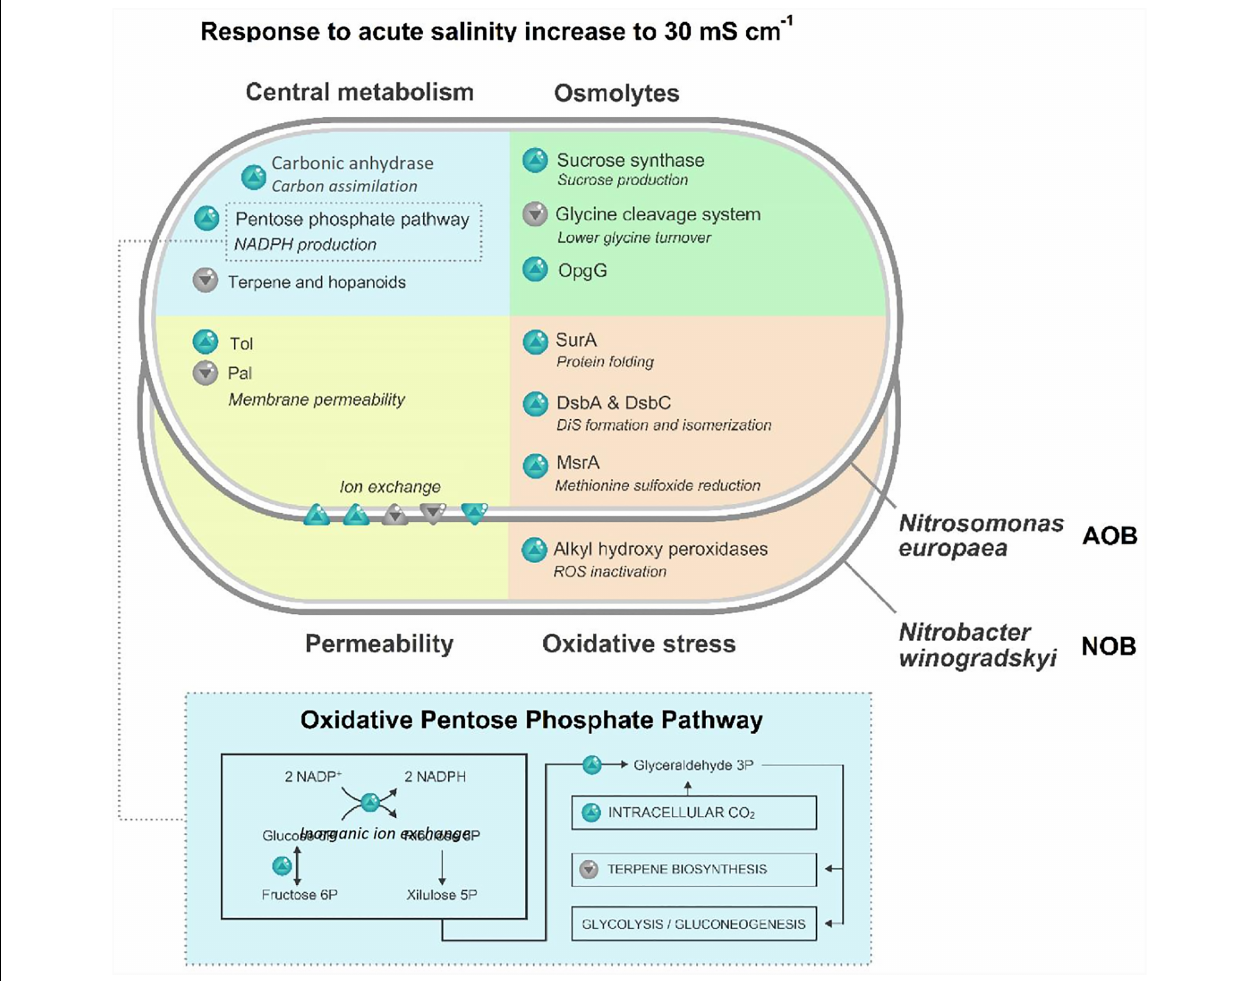
FIGURE 3 | Schematic representation of statistically significant modifications (higher than 1.5 or lower than 0.66; p < 0.05) in the proteome of the ammonia-oxidizing bacterium (AOB) N. europaea and nitrite-oxidizing bacterium (NOB) N. winogradskyi after exposure to 30 mS cm − 1 . Blue arrows indicate a higher abundance of the protein, gray arrows a lower